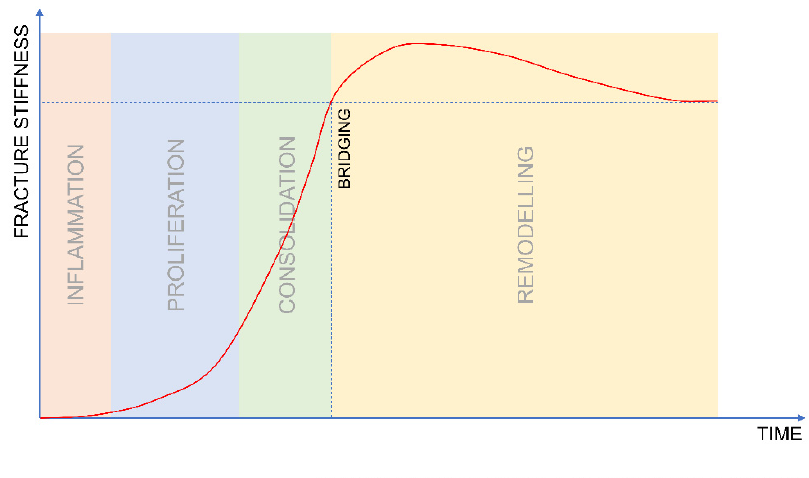
Figure 1. Pictorial representation of standard healing curve. After the initially slow increase of stiffness, the curve deflects and the rate at which stiffness increases accelerates. Bridging occurs when the fracture stiffness reaches the level of stiffness that allows for unrestricted functional loading of the bone (dashed line).